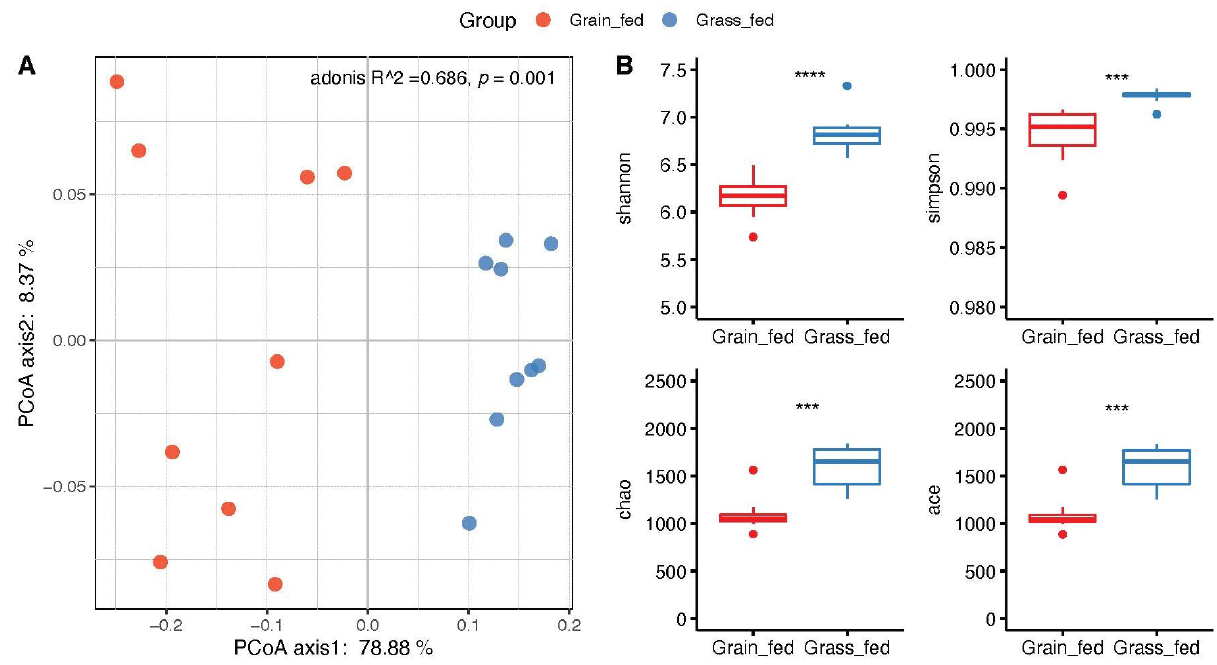
Figure 2. Community diversity analysis of grass-fed and grain-fed rumen microbiome. ( A ) Principal Component Analysis (PCoA) based on Bray–Curtis dissimilarity matrix. ( B ) Alpha diversity indices of bacterial communities between the two groups, including Shannon, Simpson, Chao1 (chao), and Abundance-based Coverage Estimator (ace). **** p < 0.001, *** p <